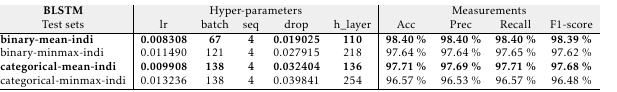
Table 7. Best binary and categorical classifiers modelled with BLSTM Algorithm; lr, batch, seq, drop and h_layer correspond to learning rate, batch size, sequence length, dropout and hidden layer size.